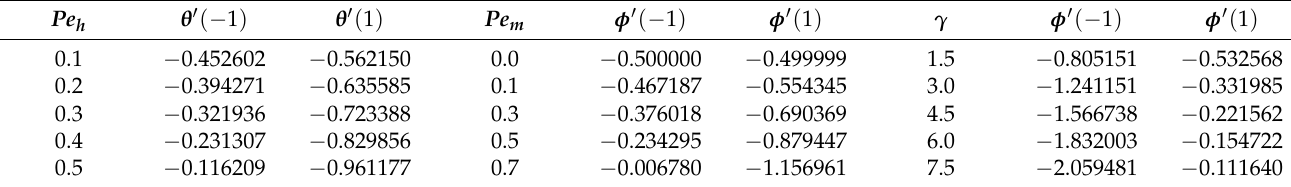
Table 6. Heat and mass transfer rates for various values of Pe h , Pe m and γ